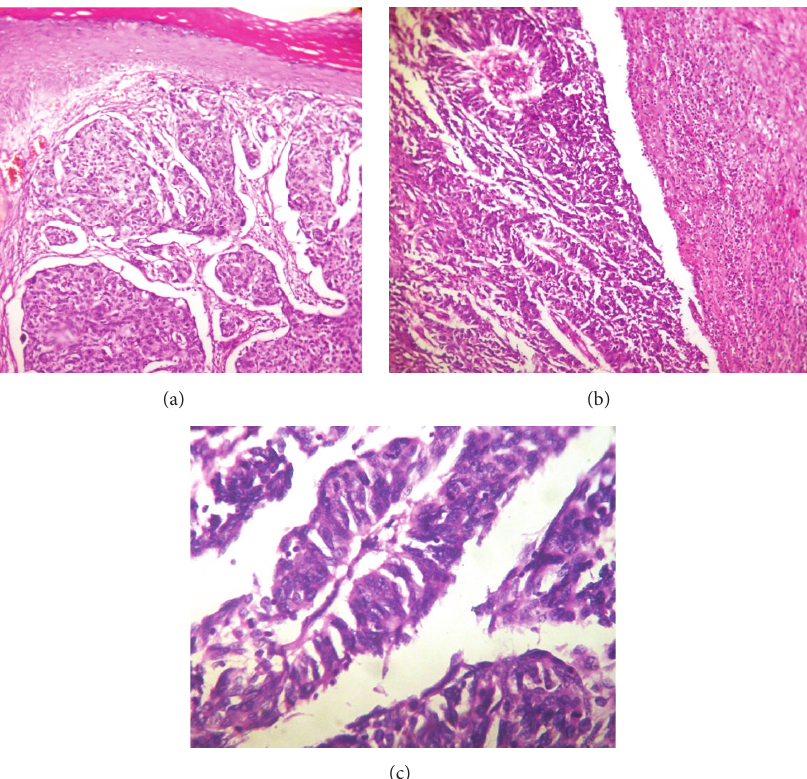
Figure 1: (a) Photomicrograph of the tumor showing epidermis and dermis along with a tumor arranged in tubules, nests, and islands invading into the deeper tissue (H&E, × 100). (b) Photomicrograph showing the tumor arranged in complex papillary fronds having central fibrovascular core; surrounding stroma shows dense lymphocytic infiltration (H&E, × 100). (c) Photomicrograph showing papillae lined by multilayered round to columnar cells showing mild to moderate nuclear atypia, with vesicular chromatin and some showed prominent nucleoli (H&E, ×